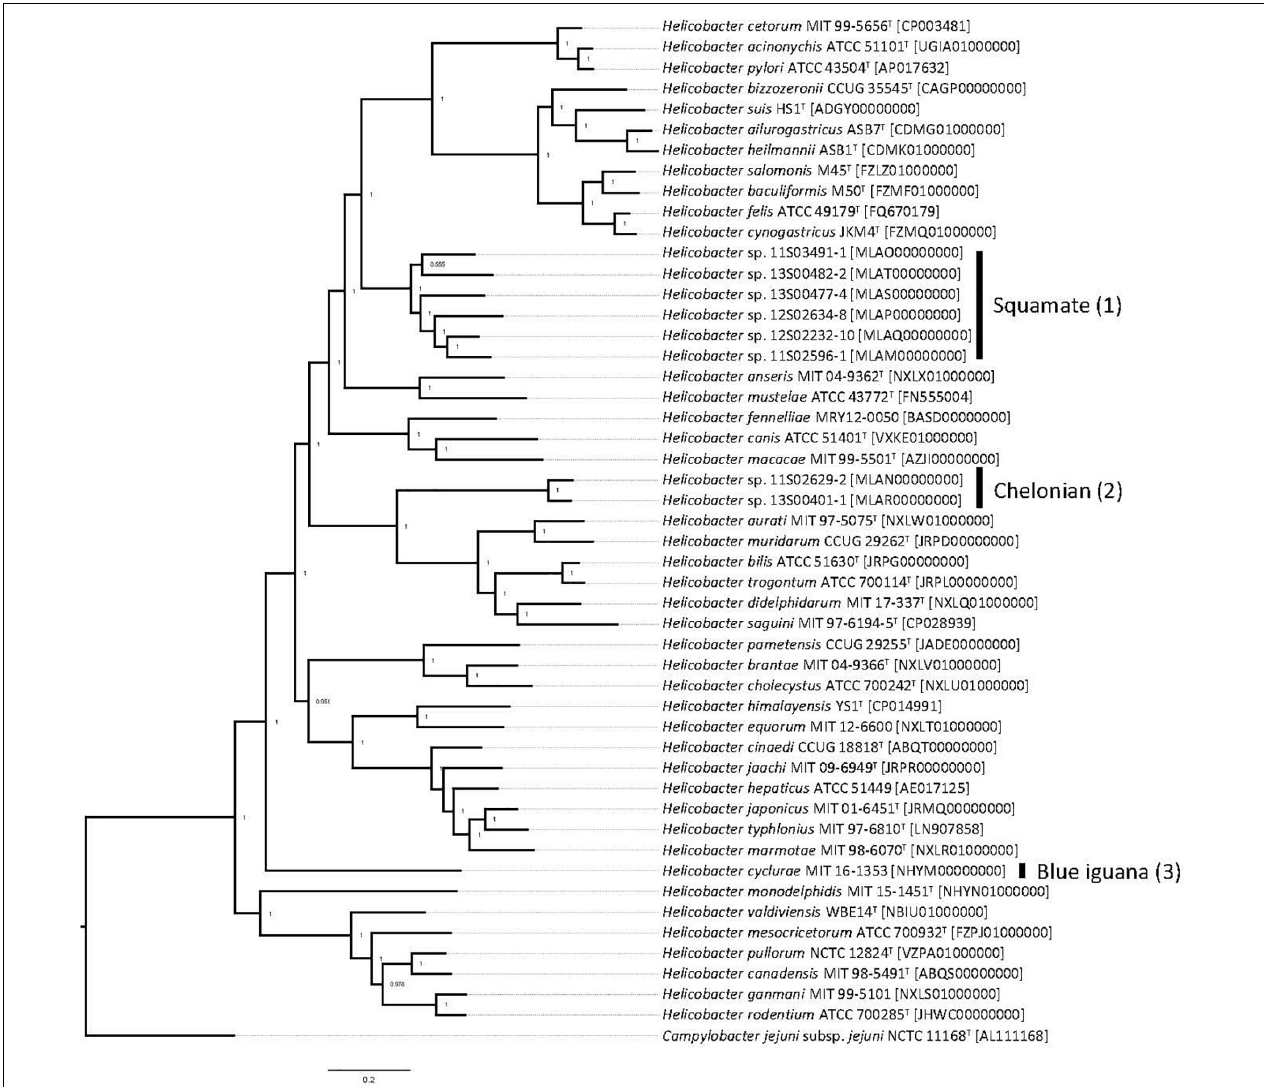
FIGURE 2 | Pan-genomic phylogenetic tree. Genomes for Helicobacter species were accessed from public databases. Type strains were used when available, and GenBank accession numbers for each genome are shown in brackets. The pan-genomic phylogenetic tree was created from the multi-sequence alignment of concatenated core gene sequences. Local support values, which indicate the reliability of each branch in the tree (0–1, lowest to highest support), were calculated by FastTree by resampling the site likelihoods 1,000 times using the Shimodaira–Hasegawa test. The scale bar indicates branch length as number of substitutions per amino acid. (1) Reptiles in the order of Chelonian: turtles and tortoises. (2) Reptiles in the order of Squamata: snakes and lizards. (3) Blue iguana: belongs to the order of